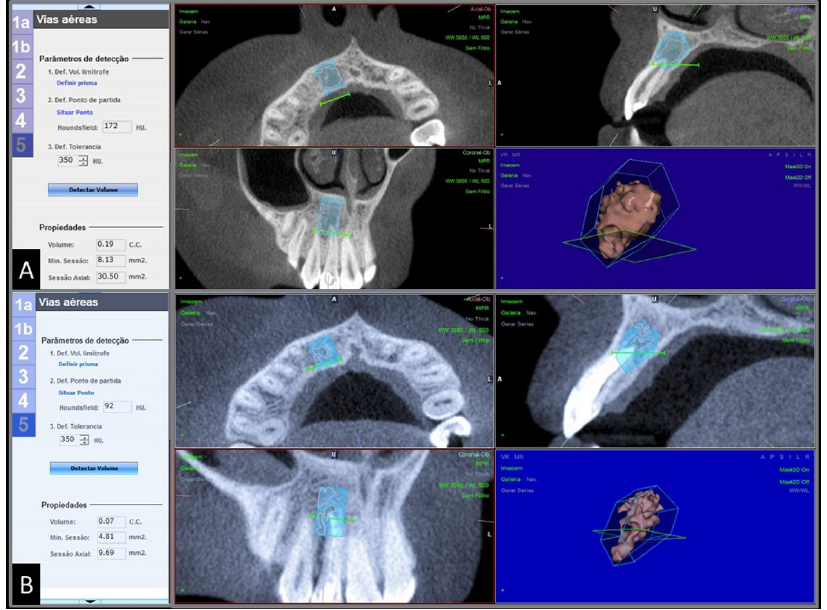
Figure 6- DICOM data of (A) preoperative and (B) 18-month follow-up analysis transferred to NEMOTEC ® software (Madrid, Spain), and 3D reconstruction of periapical